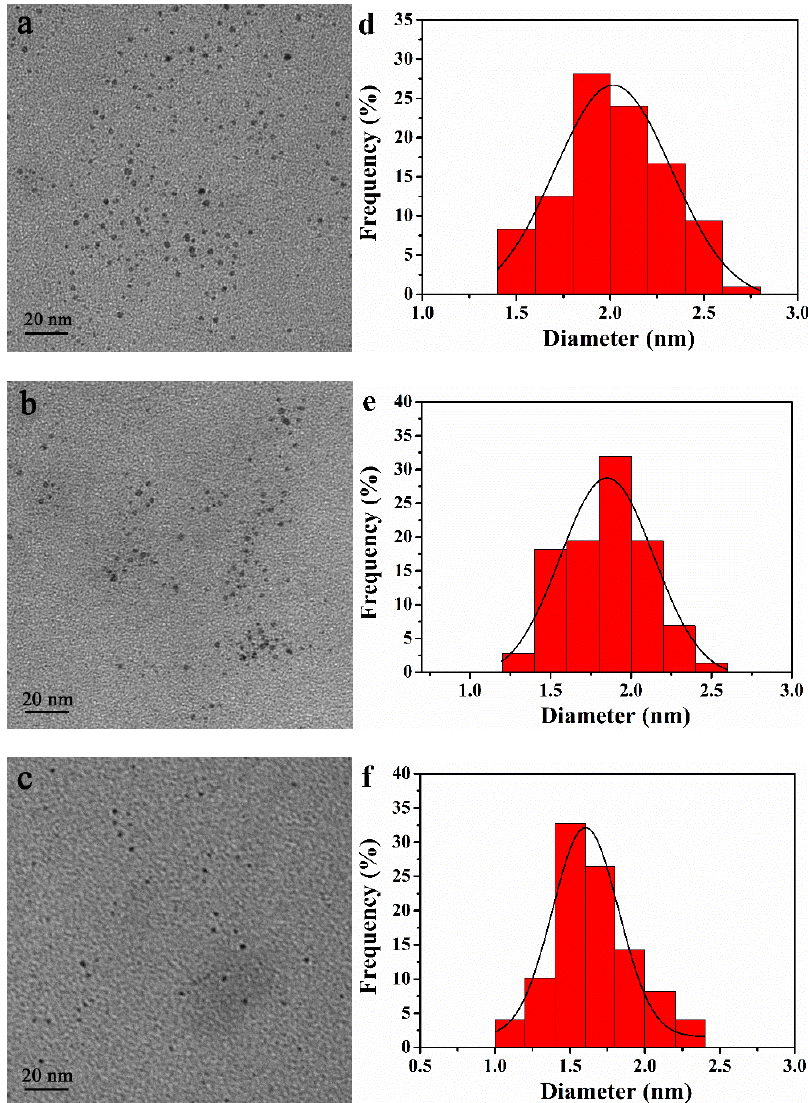
Figure 3. TEM images and size distribution analysis of the PdNPs of PO-PdNPsn: ( a , d ) n = 75, ( b , e ) n = 100, ( c , f ) n = 150.